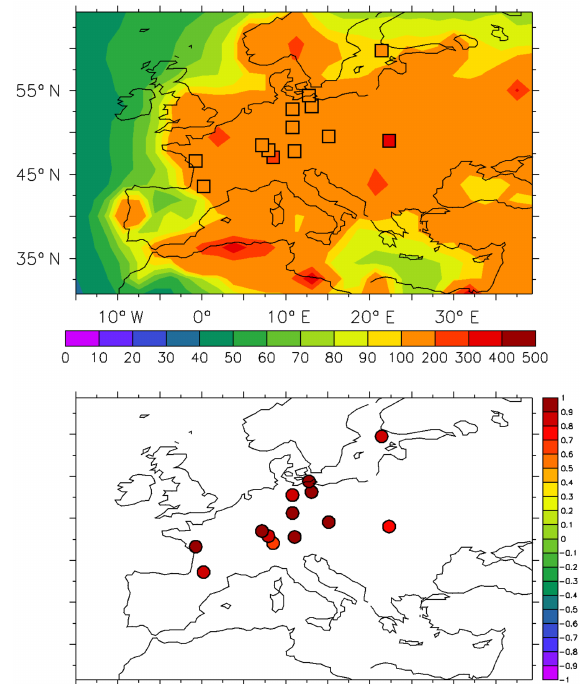
Figure 3. Top: annually averaged background mixing ratios of ben- zene for the RCP simulation, with the squares depicting annually averaged EMEP observations, both in pmolmol − 1 . Bottom: tempo- ral correlation between observations and simulations for